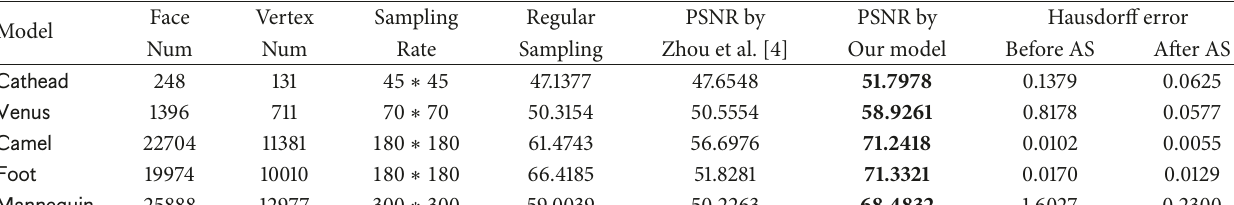
Table 1: Comparative results of PSNR values of reconstructed models.